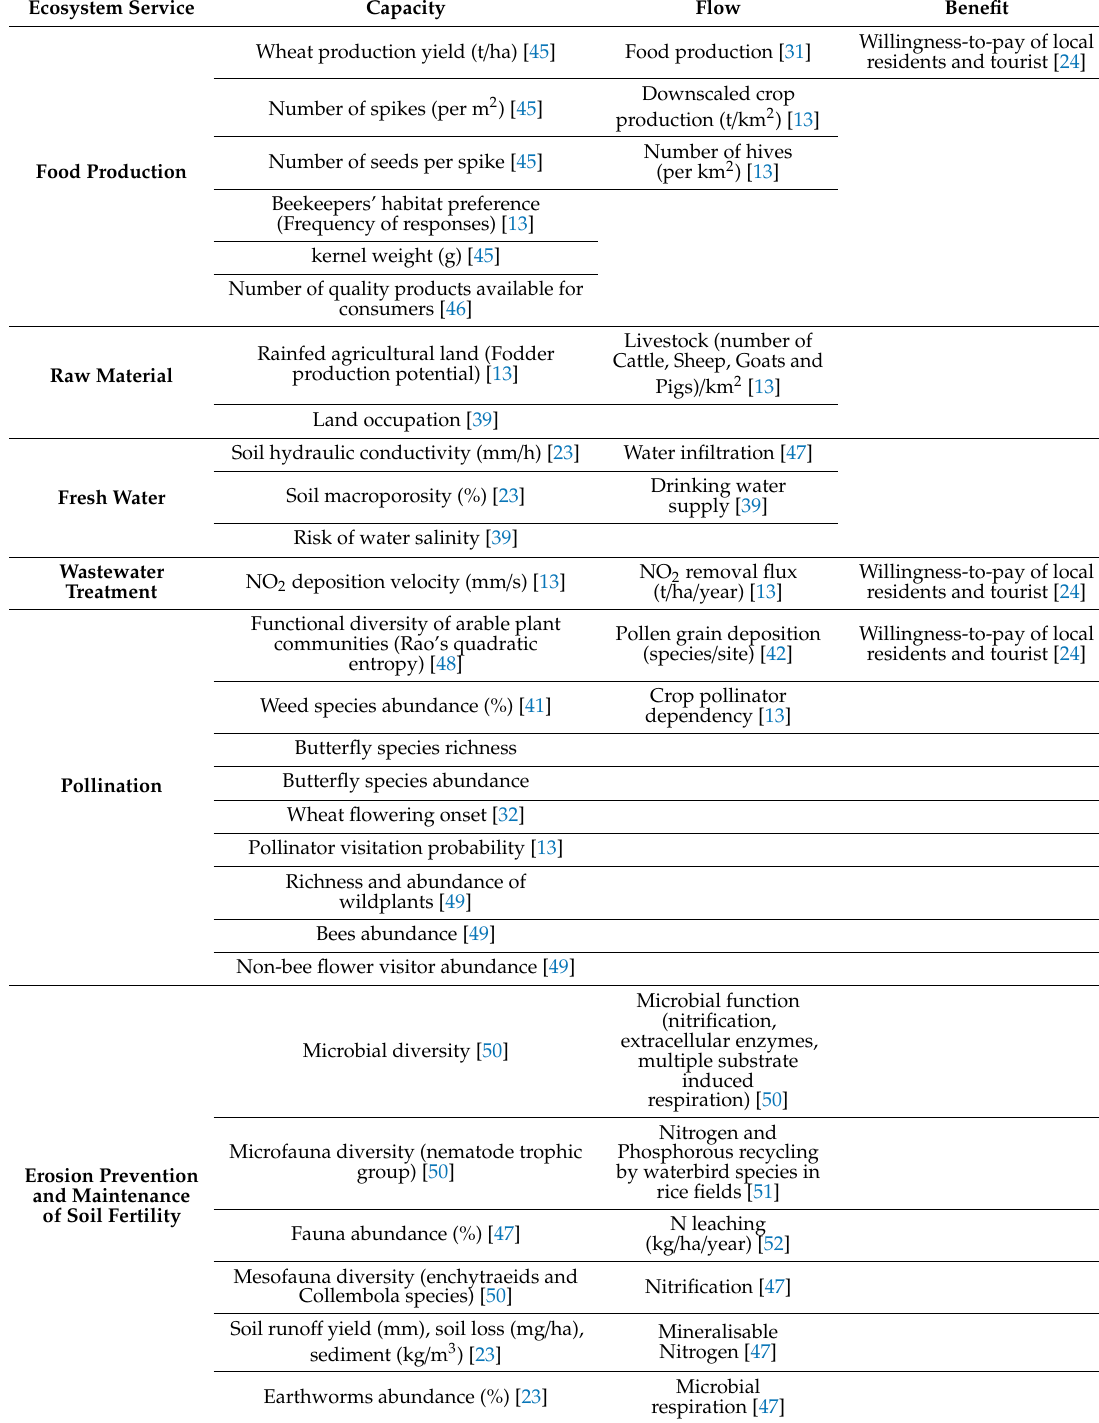
Ecosystem service indicators identified in this review as classified into capacities, flows,